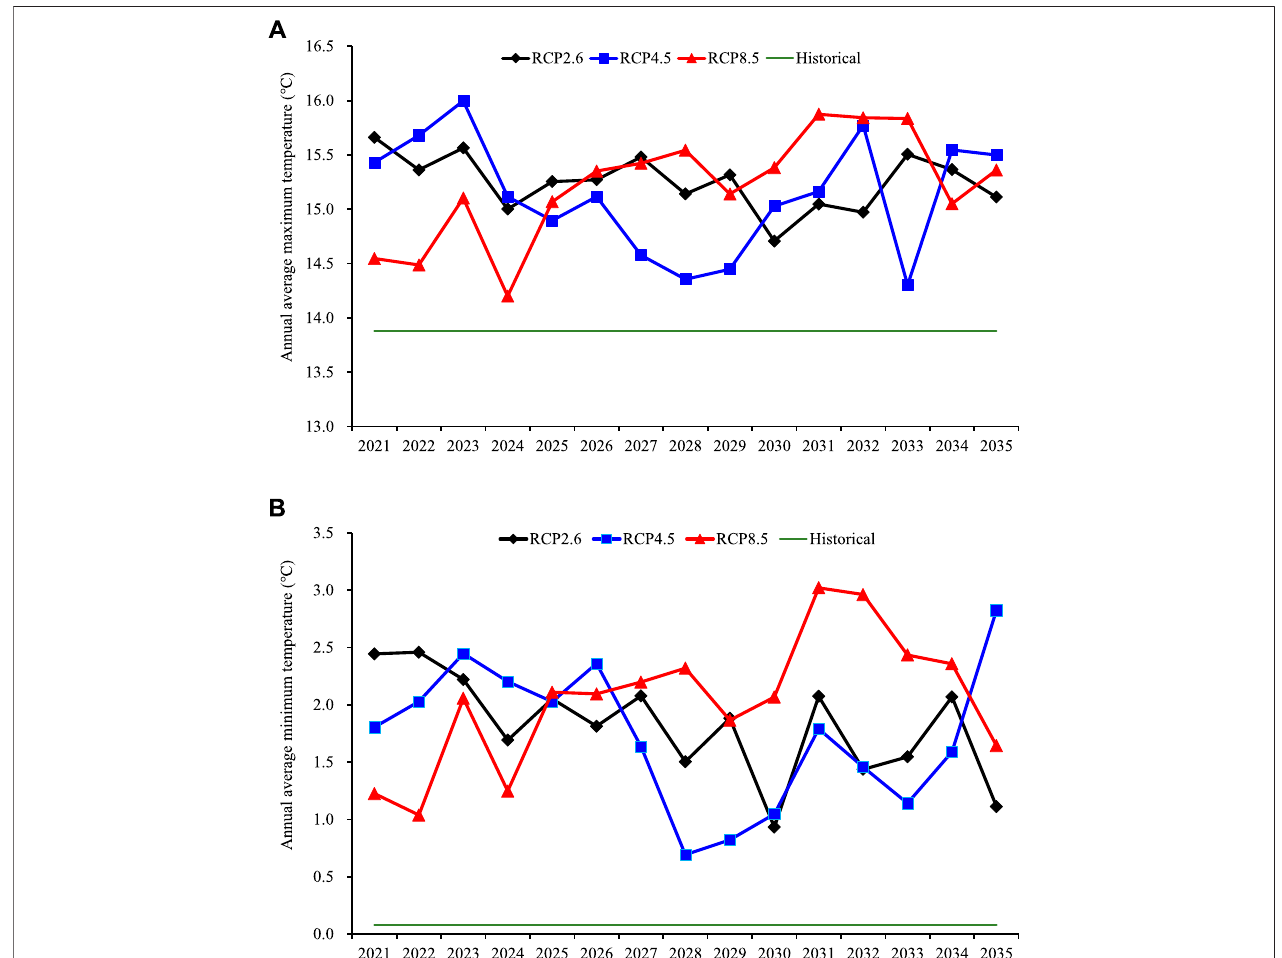
FIGURE 5 | The predicted results of the annual average